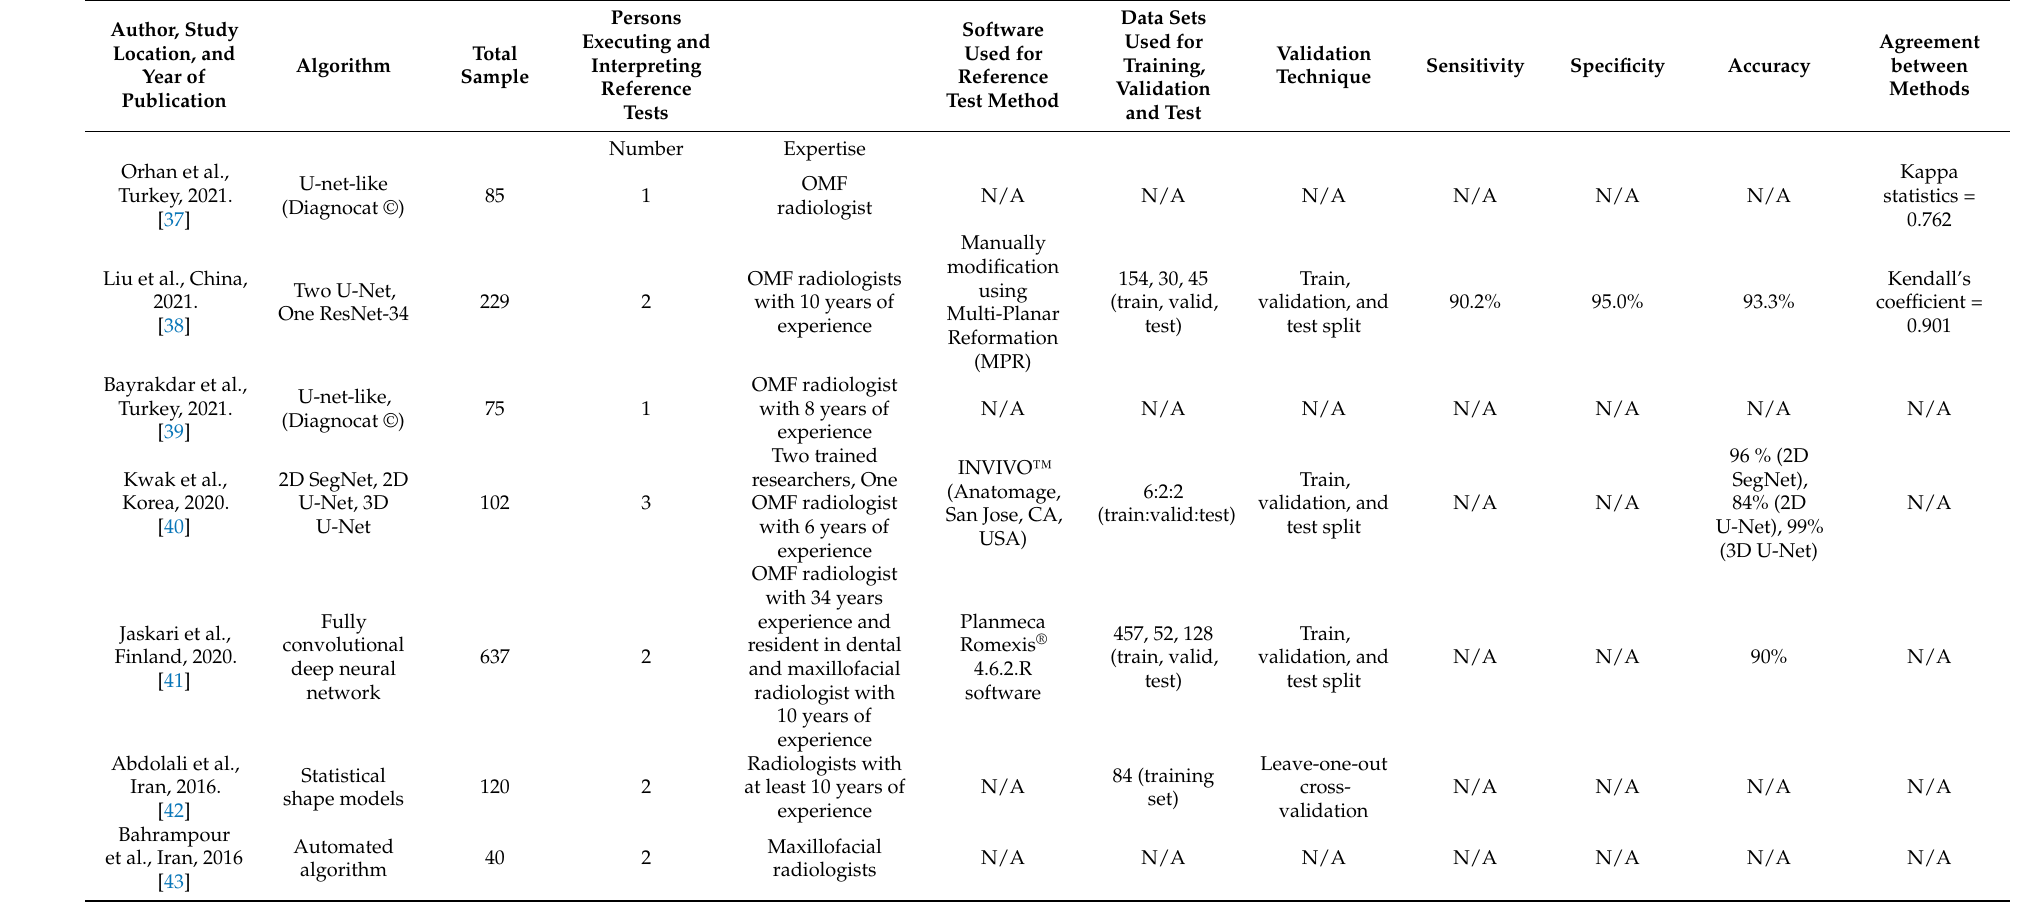
Table 2. Data extracted from included studies. OMF, Oral and